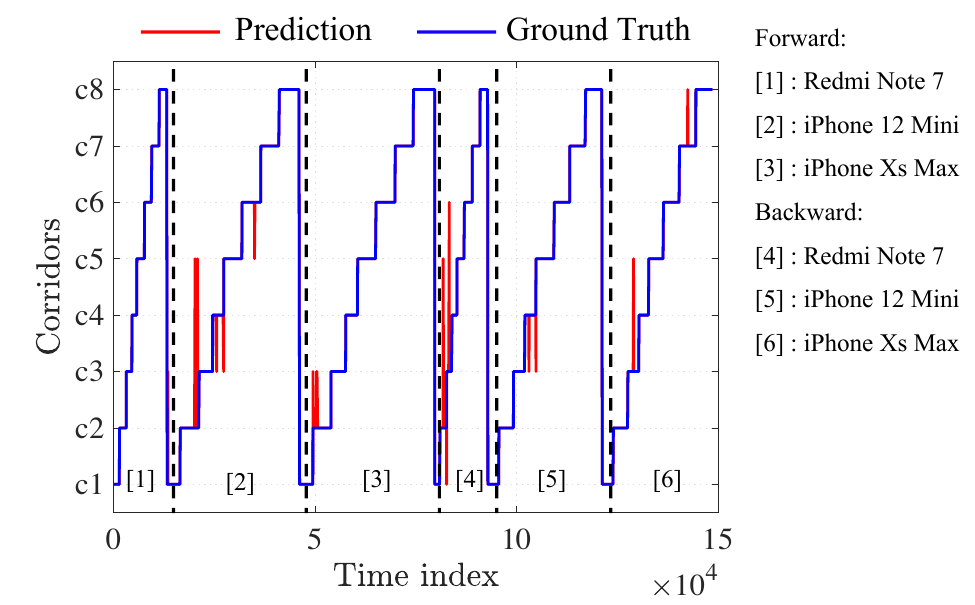
Figure 8. Test trajectory predictions.